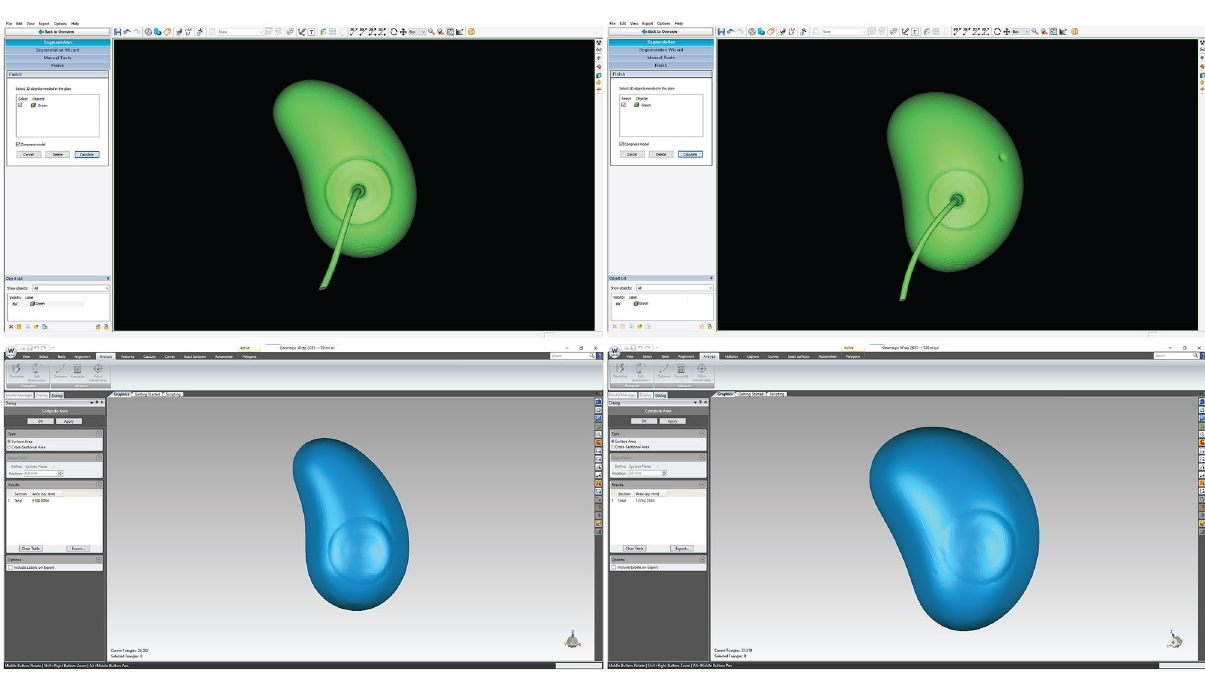
Figure 8. DICOM data of the expanders were processed in ProPlan (above), and the surface area was measured in Geomagic Wrap